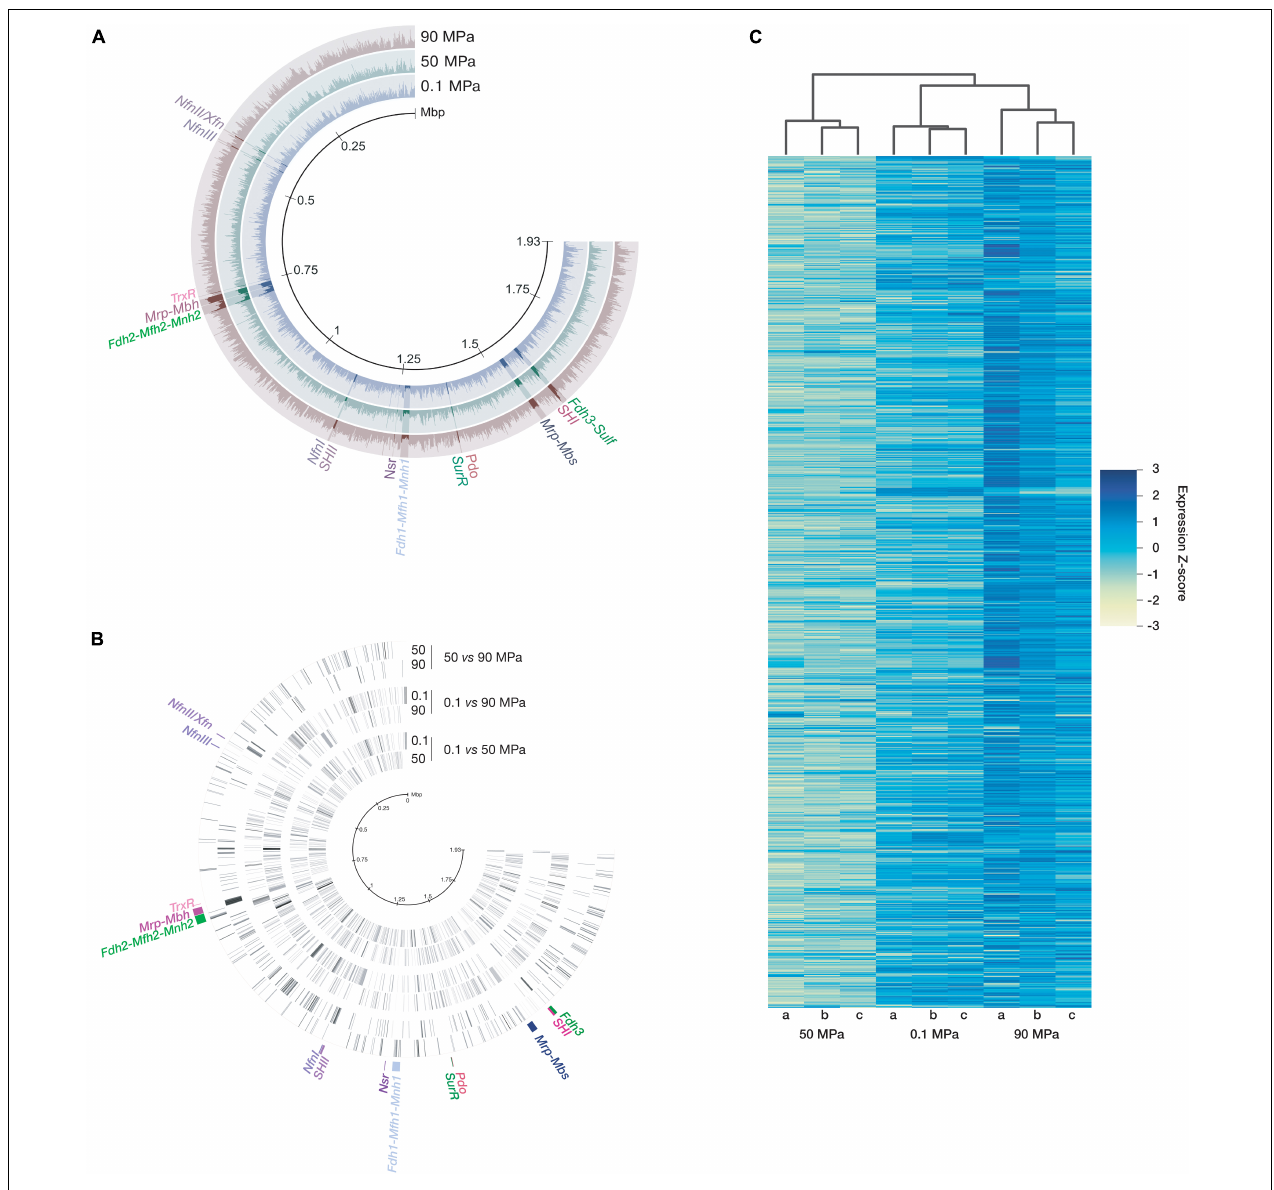
FIGURE 1 | Read mapping and differential gene expression as a function of pressure variation. After normalization, the TPM were mapped on concatenated CDSs of T. piezophilus (A) . Some of the pressure-regulated genes or gene clusters are highlighted. The concentric circles represent the 3 conditions. Each ray represents a gene expression level (B) , ordered according to the position of the gene on the genome (indicated by the scale in the center). The logFC values were used for signal intensity and the color black was given for the maximum. Key genes of the hydrogenogenic/sulfidogenic metabolisms are displayed. These representations were made with Anvi’o (Eren et al., 2015). (C) Z-score hierarchical clustering heat map for visualization of the 3 biological replicates (a, b, and c) per